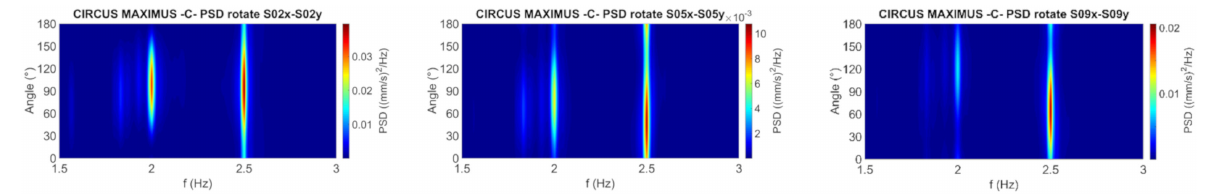
Figure 15. Circus: CSDs S02z-S05z and S02z-S09z for the three time intervals. In Figure 16, the spectral ratios between each horizontal and the vertical component are plotted for S02, S05, and S09. In almost all cases, the maximum ratio is at 1.55 Hz, with